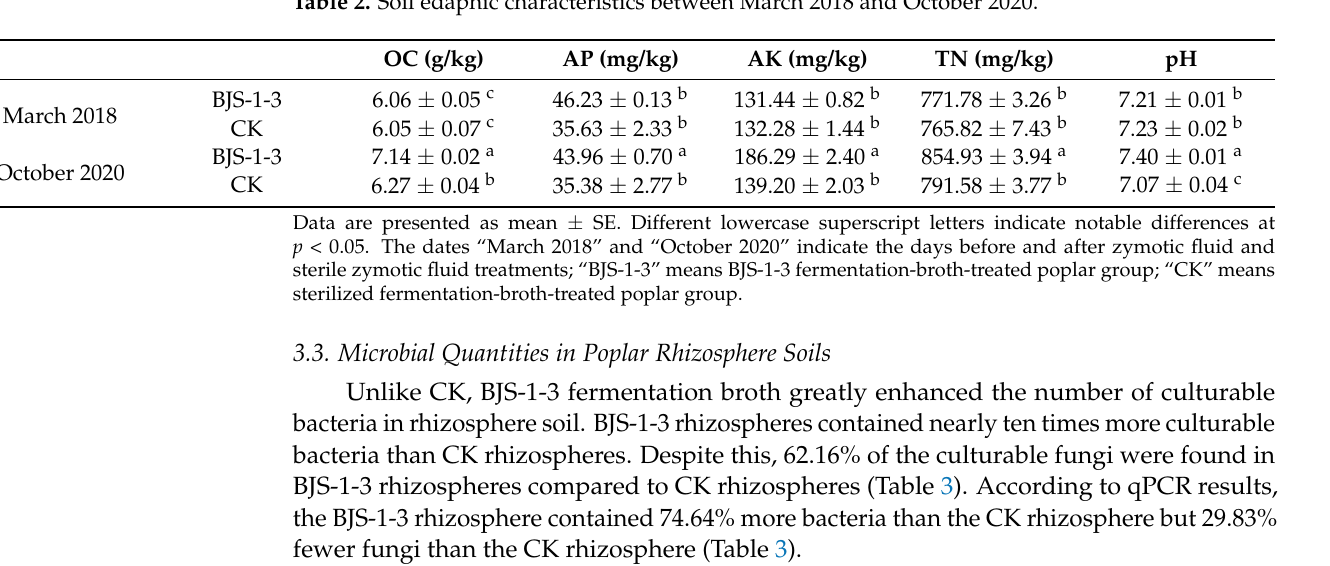
Data are presented as mean ± SE. Different lowercase superscript letters indicate notable differences at p < 0.05. “BJS-1-3” means BJS-1-3 fermentation-broth-treated poplar group; “CK” means sterilized fermentation-broth- treated poplar group.